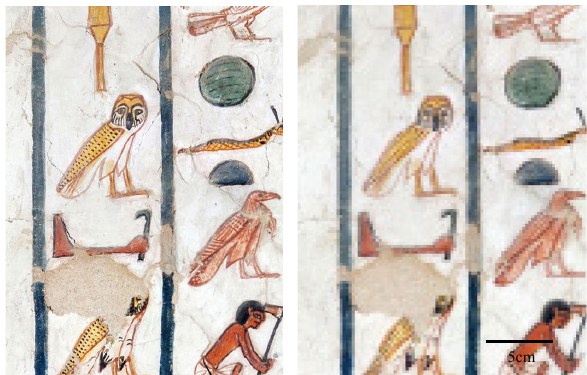
Figure 2. A detail of the orthophoto in Figure 1 captured with 0.35mm/pixel GSD (left) and the same image at 5.0mm/pixel GSD (right), demonstrating the effect of GSD on the level of visible detail (Credit: Carleton Immersive Media Studio; Carleton University. © J. Paul Getty